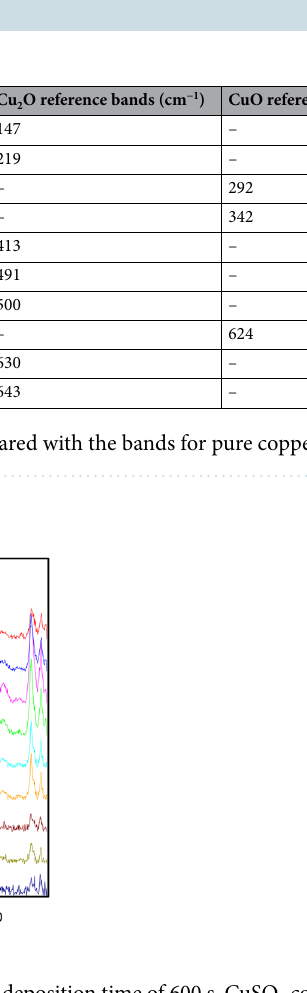
Figure 9. Raman in-depth analysis of the A7 sample (ECD deposition time of 600 s, CuSO 4 concentration of 1 mM) from the surface to the depth of 4.0 µm.